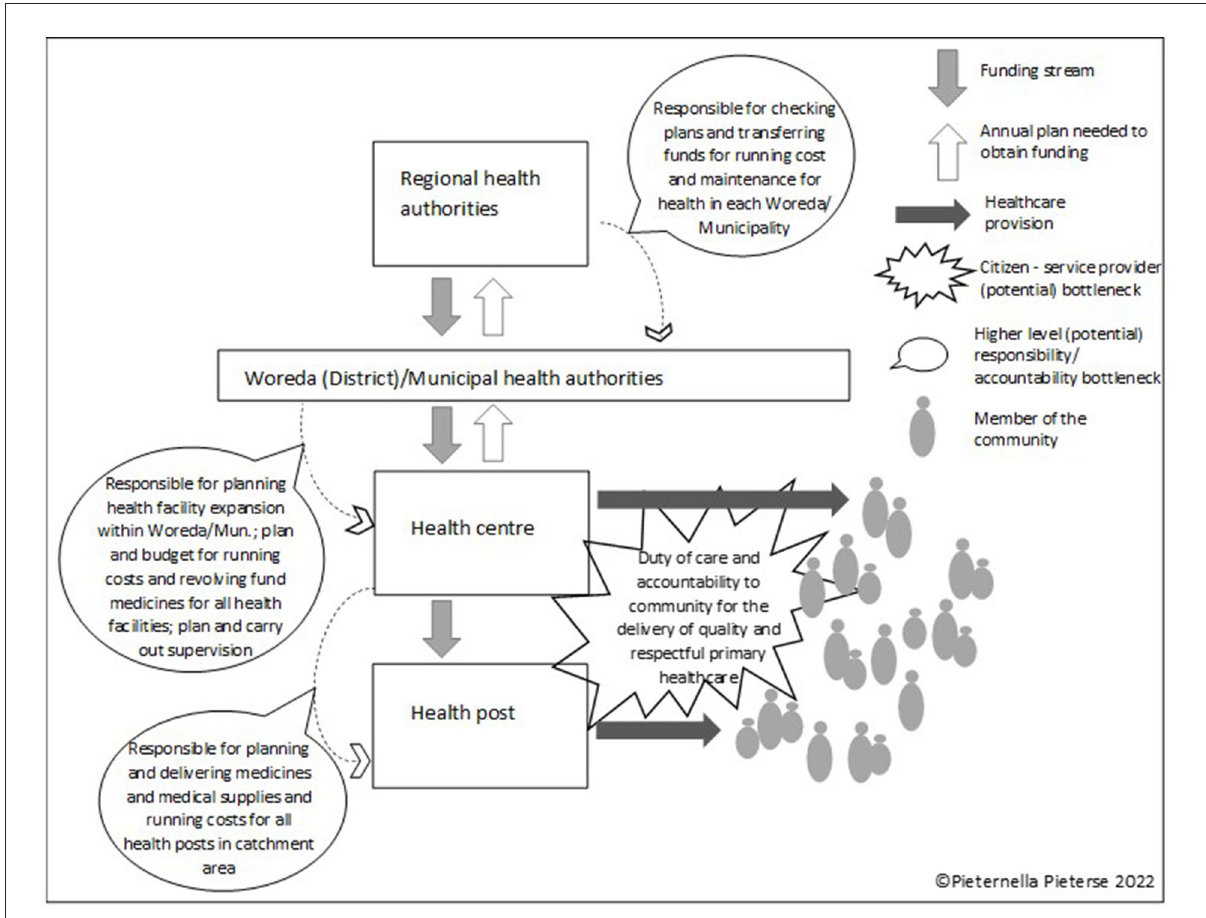
FIGURE1 Key “bottlenecks” where a lack of accountability can undermine health service